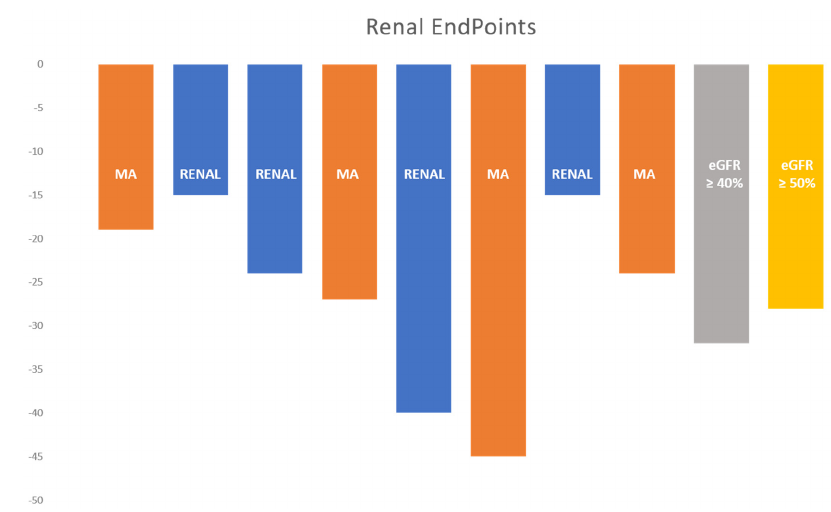
Figure 3. GLP-1RA RCT studies with known beneficial renal endpoints. Blue bars—percentage of composite renal endpoint reduction with the intervention drug. Orange bars—percentage of individual renal endpoint reduction with the intervention drug. Renal, combined renal endpoint; MA, macroalbuminuria; ↓ eGFR ≥ 40%, Sustained decline in eGFR of ≥ 40%; ↓ eGFR ≥ 50%, Sustained decline in eGFR of ≥